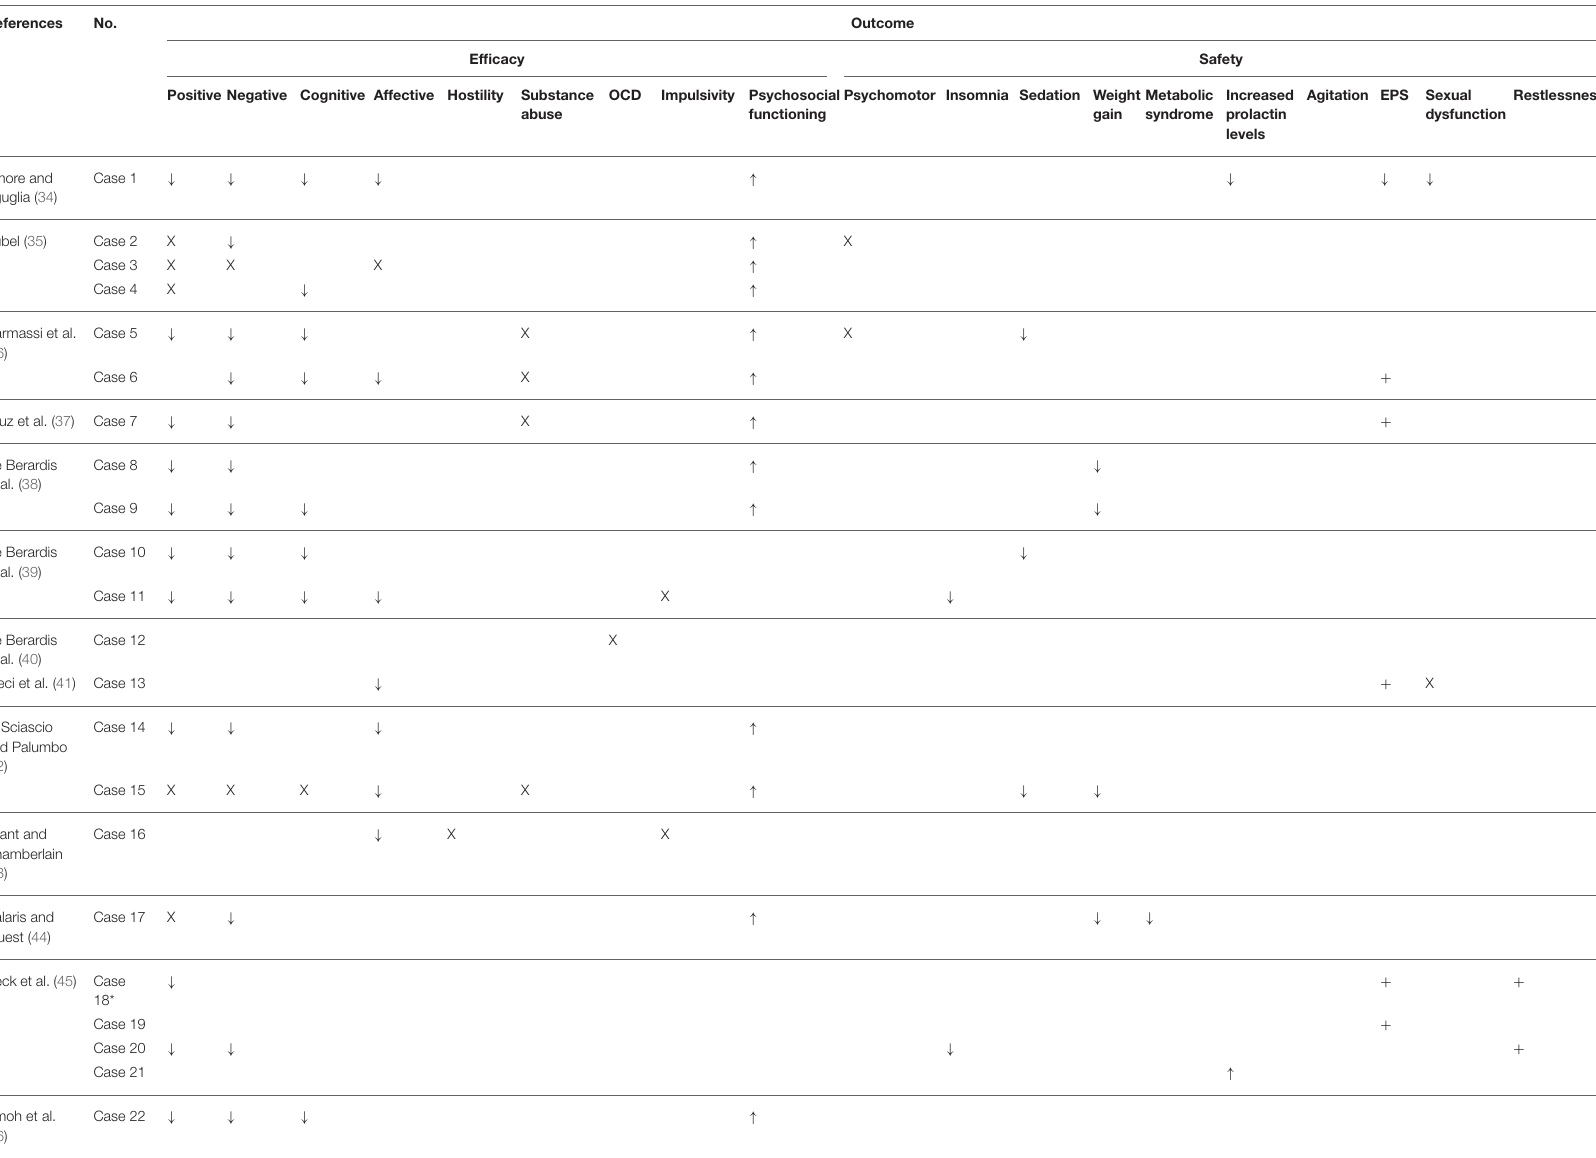
TABLE 3 | Clinical outcomes with cariprazine